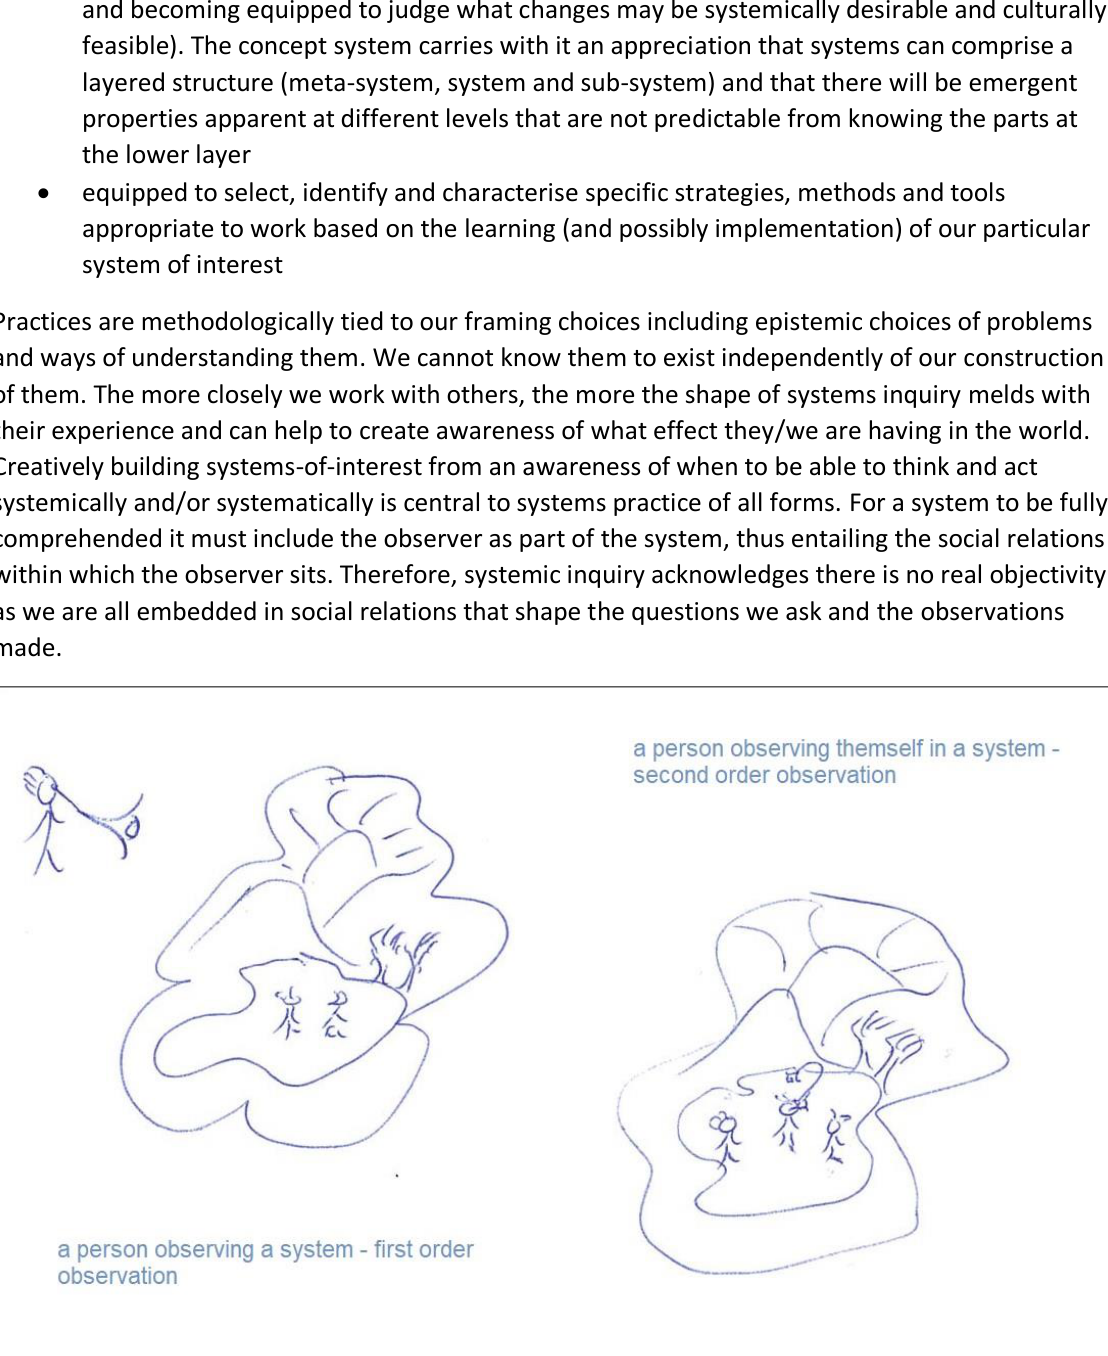
Fig A1-2: Model of first order and second order observation